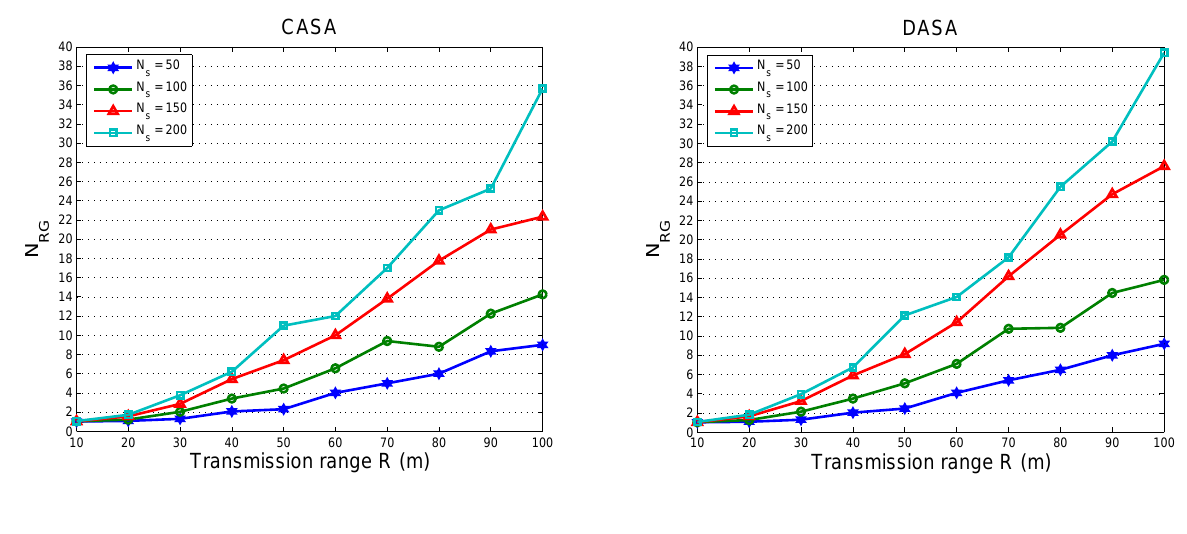
Figure 15. The relationship between the number of sensing rounds N transmission range R with varying the number of